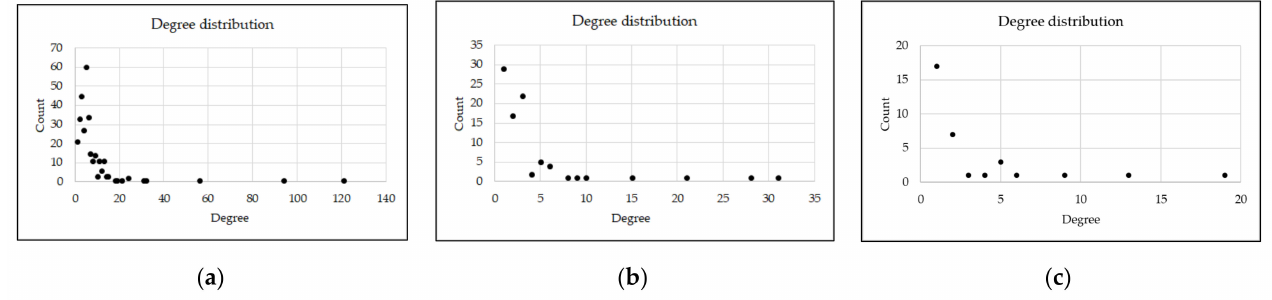
Figure 4. ( a ) Degree distribution of the network depicted in Figure 3a; ( b ) Degree distribution of the network depicted in Figure 3b; ( c ) Degree distribution of the network depicted in Figure